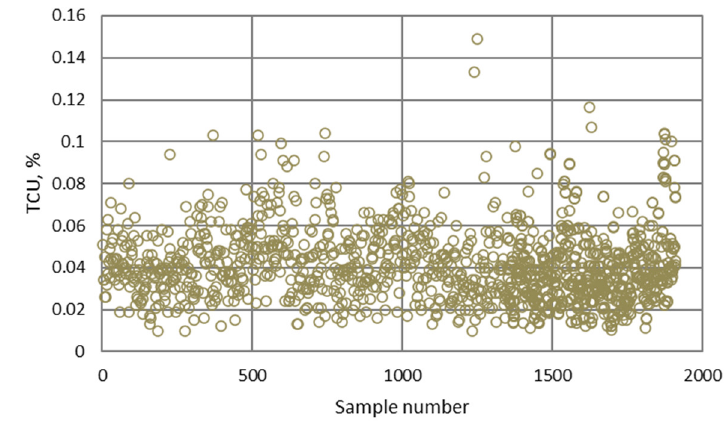
Figure A18. PMM model—training dataset for TCU output variable.